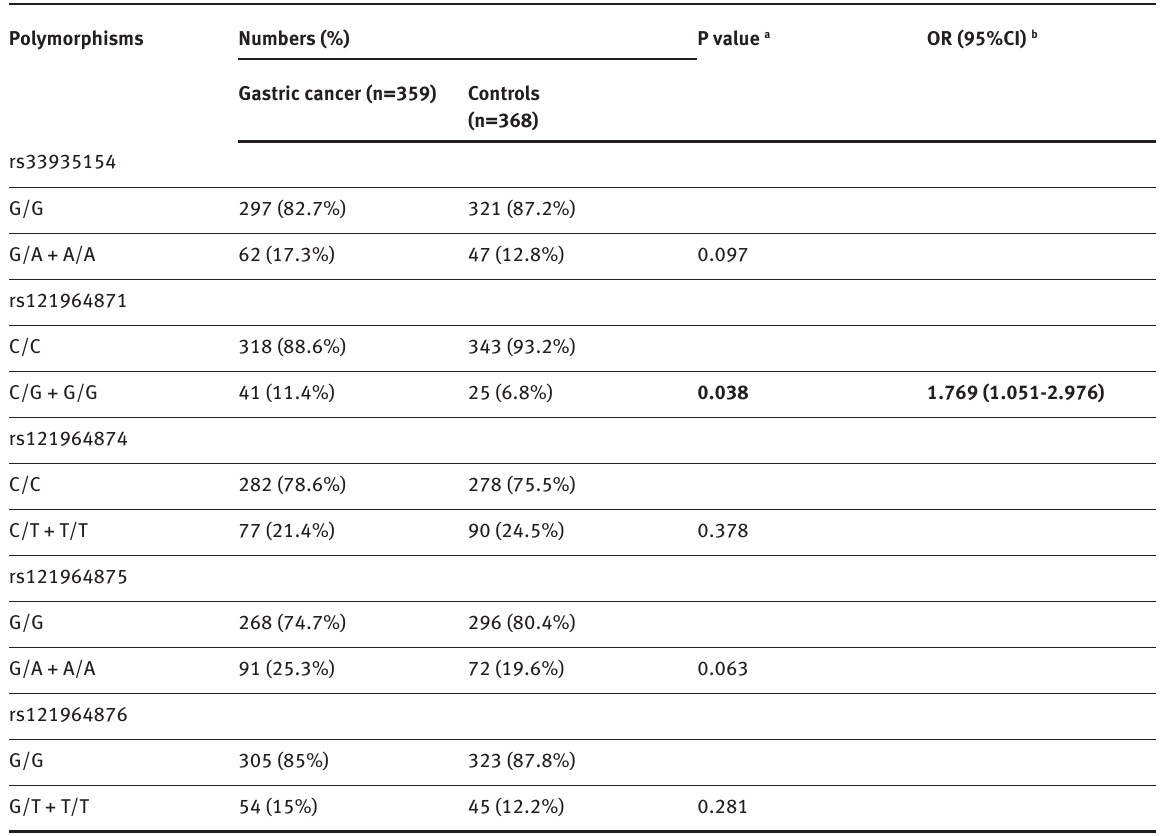
Table 2: Comparison of genotypes of 5 genetic single nucleotide polymorphisms in CDH1 gene between gastric cancer patients and healthy